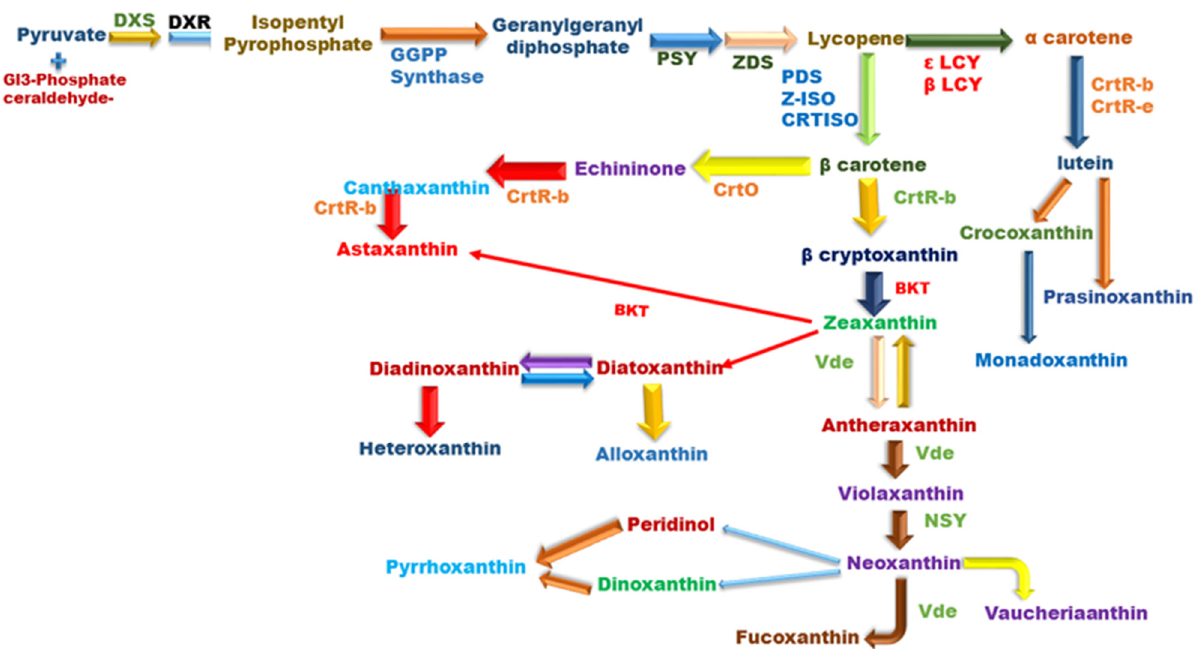
Figure 1. The overview and schematic representation of carotenoid biosynthesis, Figure, is adapted and modified from Gong and Bassi [34]. (Major enzymes involved during microalgae carotenogenesis are: ζ -carotene desaturase (ZDS), ζ -carotene isomerase (Z-ISO), Deoxy-D-Xylulose-5-phosphate Reductoisomerase (DXR), Carotenoid Isomerase (CRTISO), violaxanthin de-epoxidase (VDE), ε -cyclase ( ε -LCY), β -carotene ketolase (BKT), DXP synthase (DXS), β -cyclase ( β -LCY), GGPP synthase (GGPS), phytoene desaturase (PDS), phytoene synthase (PSY), β -carotene hydroxylase (CrtR-b), ε -carotene hydroxylase (CrtR-e), β -hydroxylase (CHY β ), neoxanthin synthase (NSY), carotene β -ketolase (CrtO/CrtW), carotene β -hydroxylase (CrtR- β )).